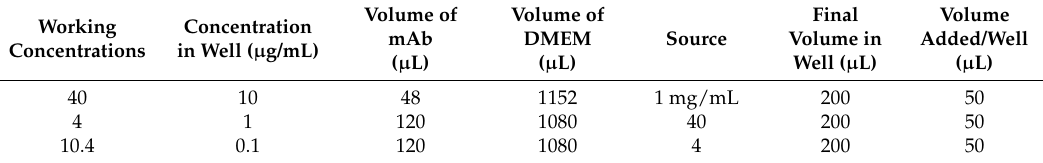
Figure A1. Layout of ( a ) ADCC, ( b ) CDCC and ( c ) CDC experiment. NC: Negative Control, PC: Positive Control, IC: Isotype Control, AICC: Antibody independent cellular cytotoxicity, EC: Effector Control. Table A1. Details of the final mAb concentration and associated dilutions.